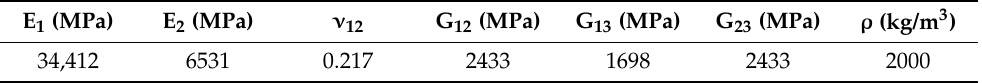
Table 2. Composite layup material properties for glass fiber epoxy resin [40].